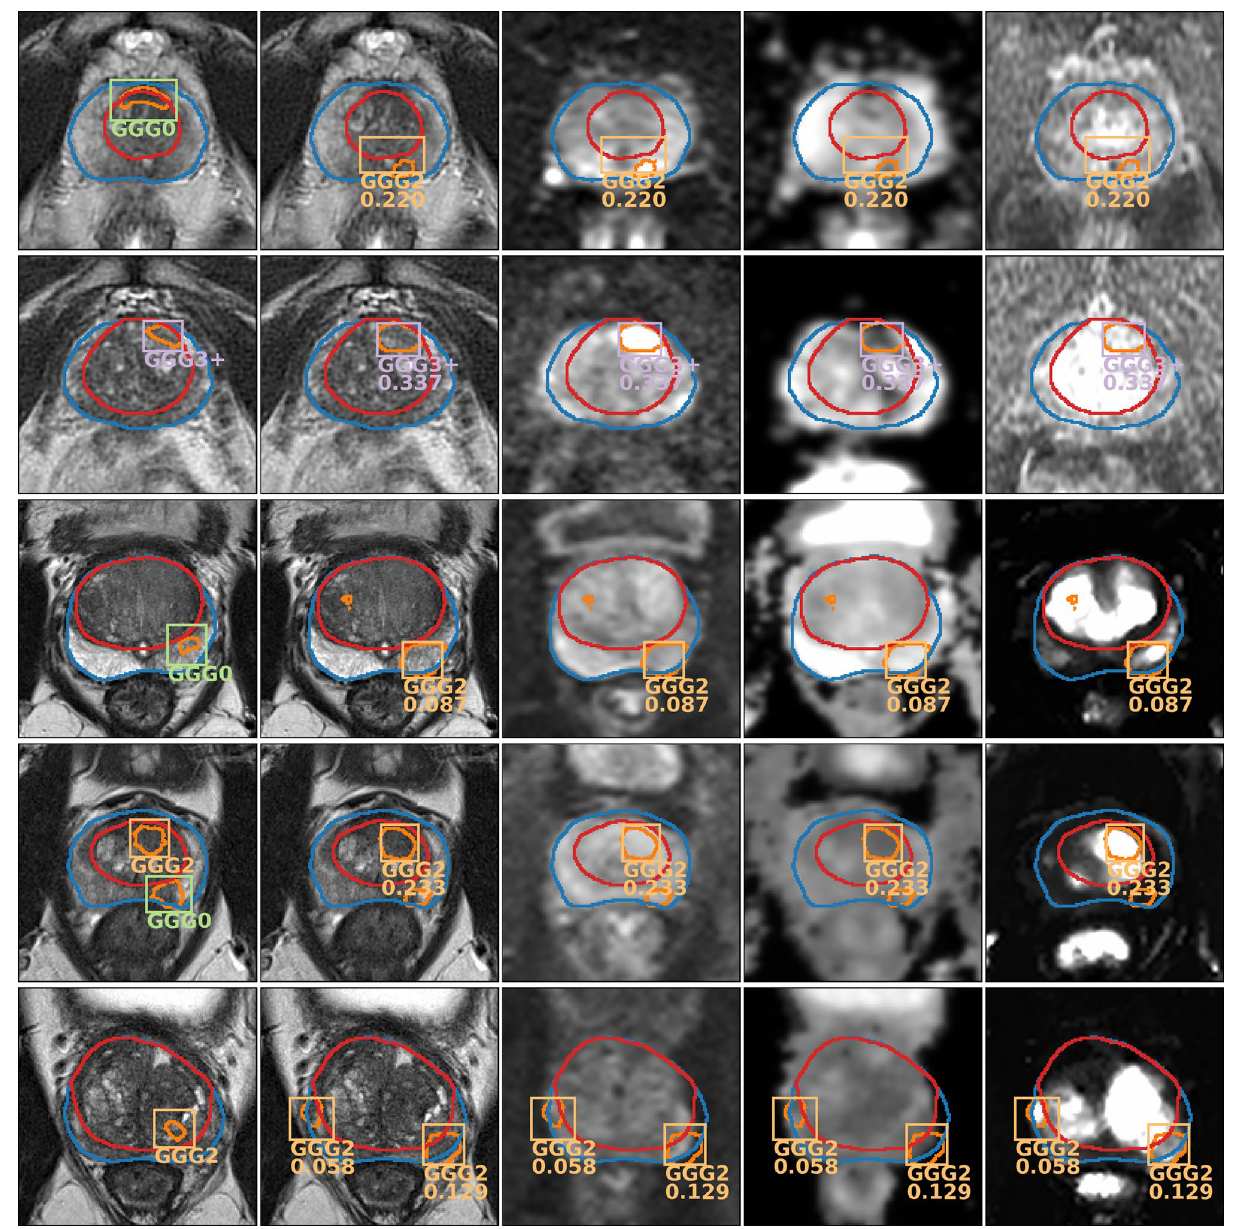
Figure 2. Output of the model (every row corresponds to a different patient) evaluated on two IVO test patients (first two rows) and three ProstateX test patients (last three rows). For each patient, first image from the left shows the ground truth on the T2 sequence; the rest show the output predictions of the model on different trans sequences (from left to right: T2, b800, ADC, K -IVO- / DCE t = 30 -ProstateX-). Gleason Grade Group (GGG) 0 -benign- bounding boxes (BBs) are not shown and only the highest-scoring BB is shown for sets of highly overlapped detections (intersection over union > 0.25 ). Detections with confidence below the GGG ≥ 2 lesion-wise maximum sensitivity threshold (0.173 for IVO, and 0.028 for ProstateX) are not shown for ProstateX) are not shown either. The first IVO patient (Fig. 2, row 1) is of special interest, as it is one of the relatively few IVO cases where the targeted biopsy did not find csPCa (as evidenced by the GGG0 BB in the GT image to the left), but the massive biopsy (20–30 cylinders) detected GGG2 csPCa. As can be seen, the model was able to detect this GGG2 lesion while ignoring the benign GGG0 one, hence outperforming the radiologists for this particular instance. For the second IVO patient (Fig. 2, row 2) a GGG3+ GT lesion (GGG4 specifically) was properly detected by the model with very high confidence. The first ProstateX patient (Fig. 2, row 3) is a case of failure, where the model detects a non-existent GGG2 lesion, albeit with relatively low confidence; in fact, it would have been ignored at the balanced sensitivity setting ( t = 0.108 ). For the next patient (Fig. 2, row 4), the model has been able to segment both GT lesions; however, only the csPCa lesion is detected, while the other is ignored (actually, the model correctly detected the other